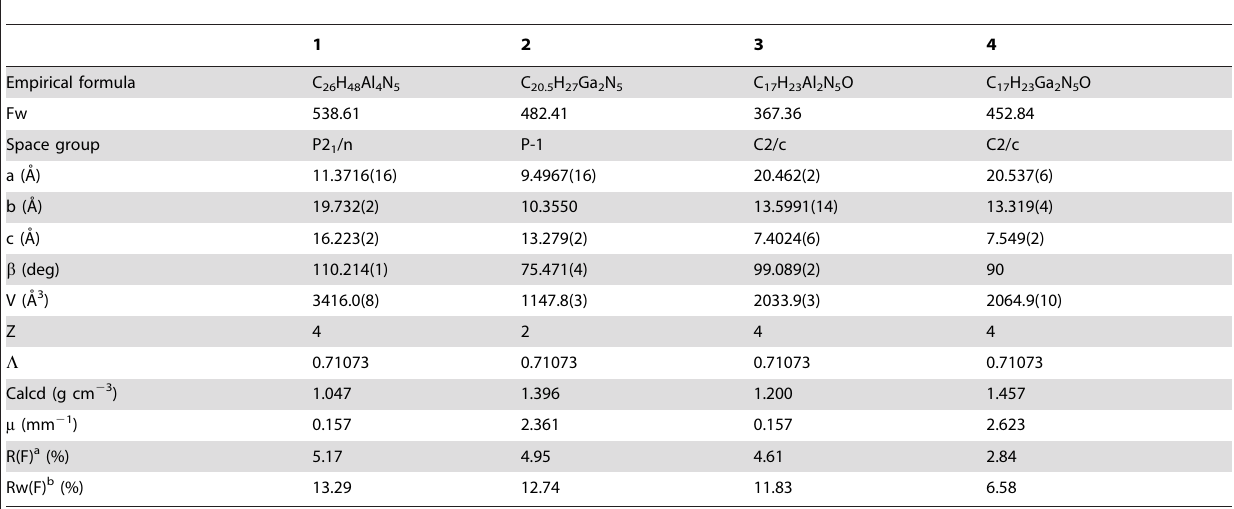
Table 1. Experimental Crystallographic data for 1 – 4 .